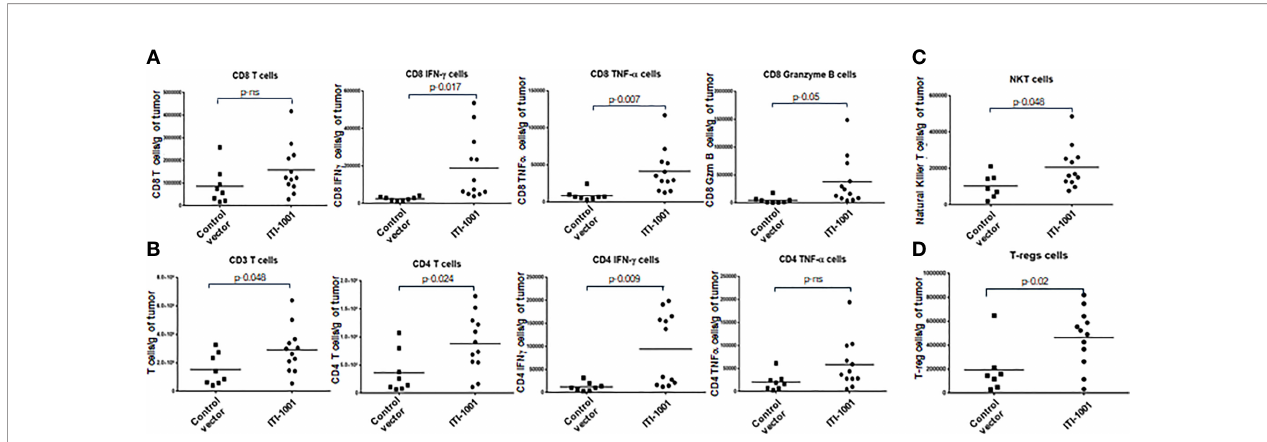
FIGURE 3 | ITI-1001 activates CD4, CD8, and NK T cells in the tumor microenvironment (TME) along with immunosuppressive regulatory T cells. (A) Flow cytometric data for total and activated CD8 T cells in the TME with and without ITI-1001 vaccination. For CD8 T-cell activation, intracellular staining of IFN g , TNF a , and granzyme B are shown. (B) Flow cytometry data for total T cells and total and activated CD4 T cells in the TME with and without ITI-1001 vaccination. For CD4 T-cell activation, intracellular staining of IFN g and TNF a is shown. (C, D) Flow cytometry data showing natural killer T cells and Tregs respectively in the TME from the two groups. All the populations are denoted as cell numbers per gram of tumor. p values from Student ’ s t-test are denoted to signify the statistical differences between the control and treated